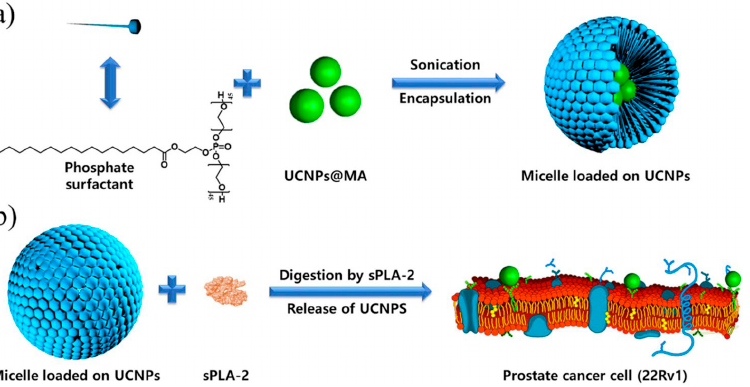
Figure 4. Schematic illustration of encapsulation procedure and release mechanism of biocompatible upconversion nanoparticles (UCNP). ( a ) Encapsulation of UCNPs in a novel, synthesized phosphate surfactant through sonication at rt. ( b ) Release of UCNPs after a specific cleavage of phosphate surfactant by the sPLA ‐ 2 enzyme. (Reprinted from [75], license CC BY 4.0.) Renu et al. [76] considered green ‐ chemistry (plant extract) ‐ mediated synthesized